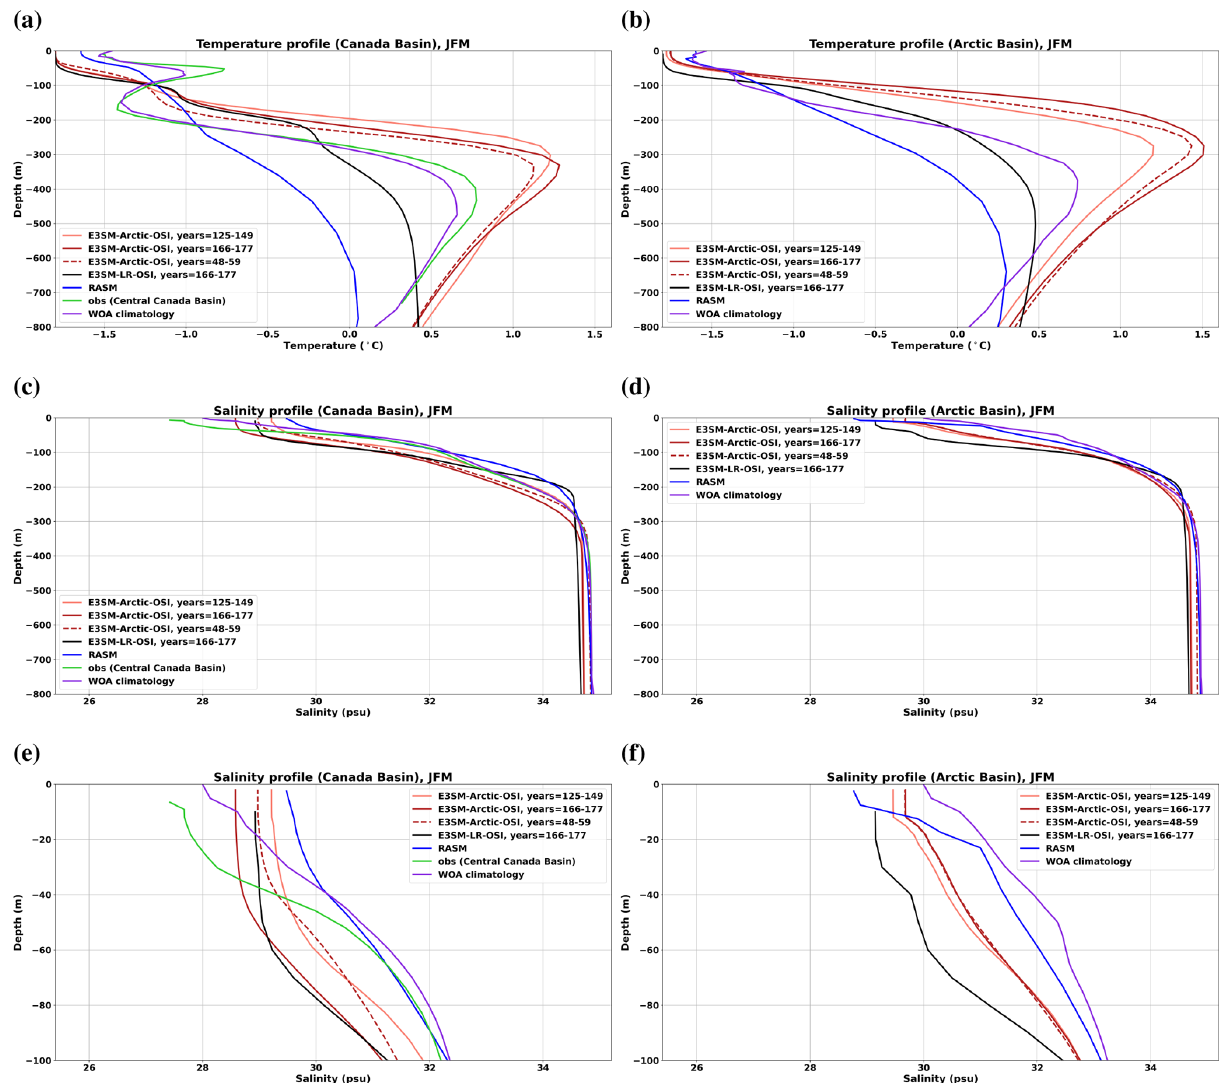
Figure 14. Vertical profiles of (a, b) temperature, (c, d) salinity, and (e, f) upper 100m salinity for the JFM seasonal climatology, computed over the Canada Basin (a, c, e) and over the whole Arctic Basin ( b, d, f ; Barents and Kara seas are not included in this calculation). Light red lines indicate E3SM-Arctic-OSI model climatologies computed over the early period (years 125–149) of the third JRA cycle (corresponding to 1964–1988), whereas dark red solid lines are for model climatologies computed over years 166–177 (corresponding to 2005–2016, which is the period for which observations are available in the Canada Basin). Dashed dark red lines are for model climatologies computed over years 48–59 (end of the first JRA cycle). Black lines represent E3SM-LR-OSI climatologies over years 166–177; blue lines indicate RASM model climatologies computed over years 2005–2014; purple lines indicate values from the WOA18 climatology; and finally green lines in panels (a) , (c) , (e) indicate observational values from the ITP buoys data in the Central Canada